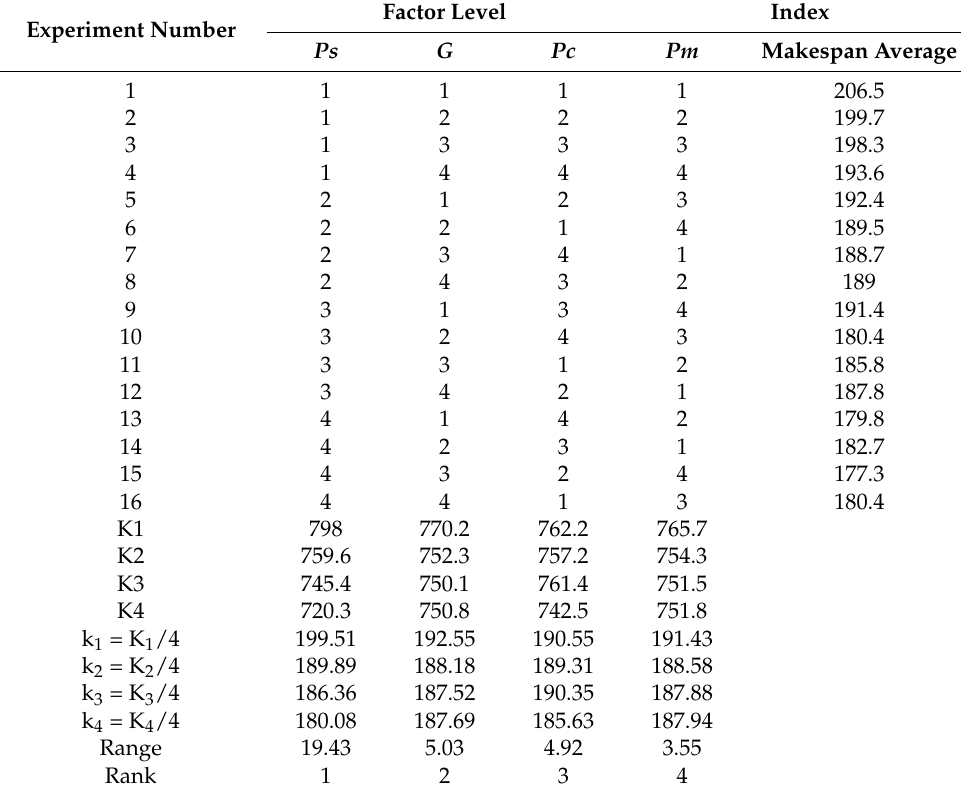
Table 3. Orthogonal test